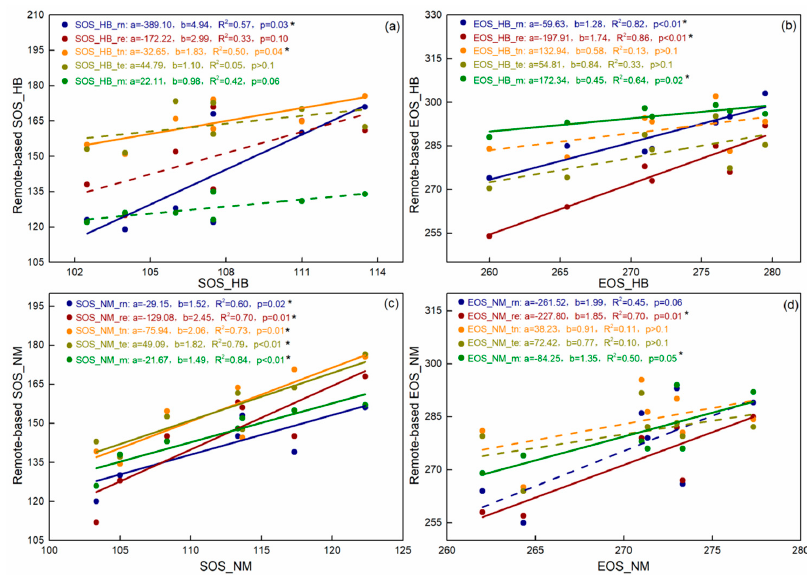
Figure 5. Verification of the accuracy of five different methods for calculating vegetation phenological period in Haibei (HB) and Inner Mongolia (NM) grasslands based on field phenology observations. b values in ( a – d ) are the linear slope between field phenology observations and satellite-based phenology estimations, respectively. All solid lines are significant trends ( p < 0.01) and the dash lines are nonsignificant trends ( p > 0.05). Colors in ( a – d ) are one-to-one corresponding with five satellite-based phenology estimations (Table